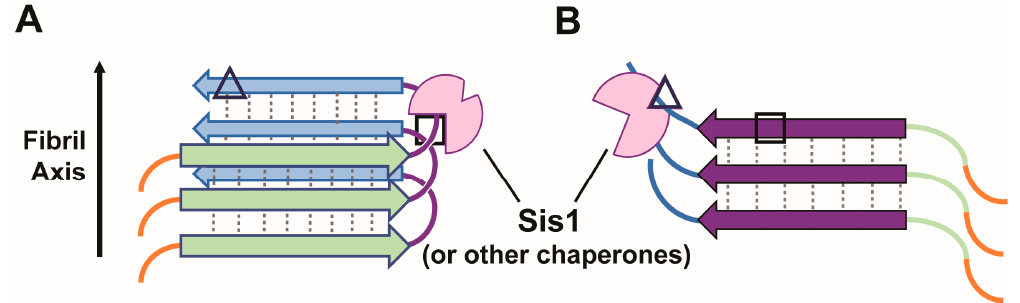
Figure 2. Prion variants may expose or obscure binding sites for distinct chaperone domains. Examples of two prion variants (“ A ” and “ B ”) in which di ff erent regions form the amyloid core, assumed here to be in-register parallel beta-sheet. The structural basis of yeast prion amyloids is debated, as is the structural nature of variants. See Wickner et al. for a recent review [99]. The solid arrow represents the direction of growth of the amyloid fibril, while dashed lines represent hydrogen bonds between parallel, in-register β -strands (horizontal arrows) that restrict the binding of chaperones to sites within the amyloidogenic regions. These sites (triangle and square) vary in structure when exposed and therefore may be recognized by distinct binding modes or domains of Sis1 and / or other chaperone proteins (pink cartoon). Thus, binding occurs only when the site is exposed, i.e., not part of the amyloid core.